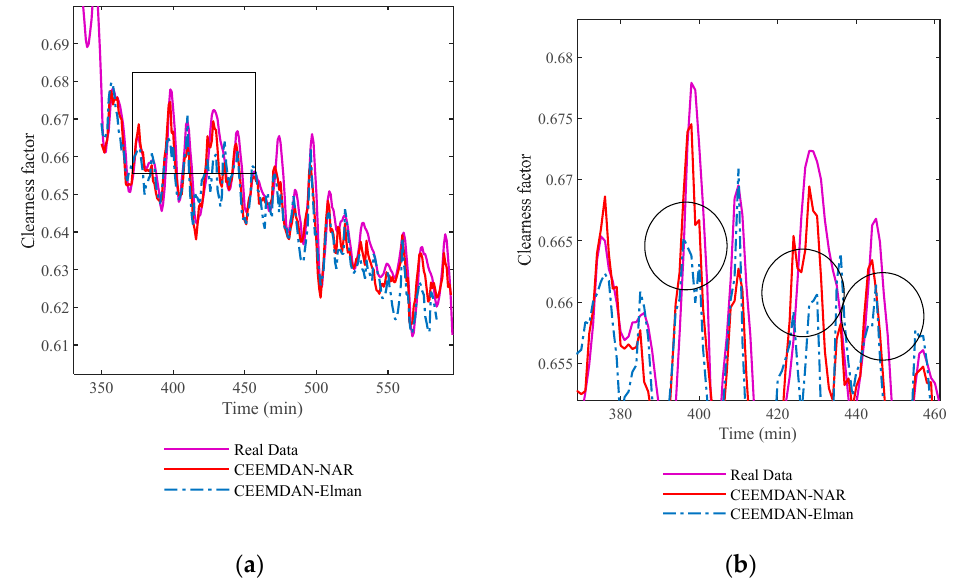
Figure 6. Five ‐ step ‐ ahead prediction of M1, M3 using CEEMDAN ( a ) and partial enlarged figure Figure 6. Five-step-ahead prediction of M1, M3 using CEEMDAN ( a ) and partial enlarged figure ( b ). ( b ).